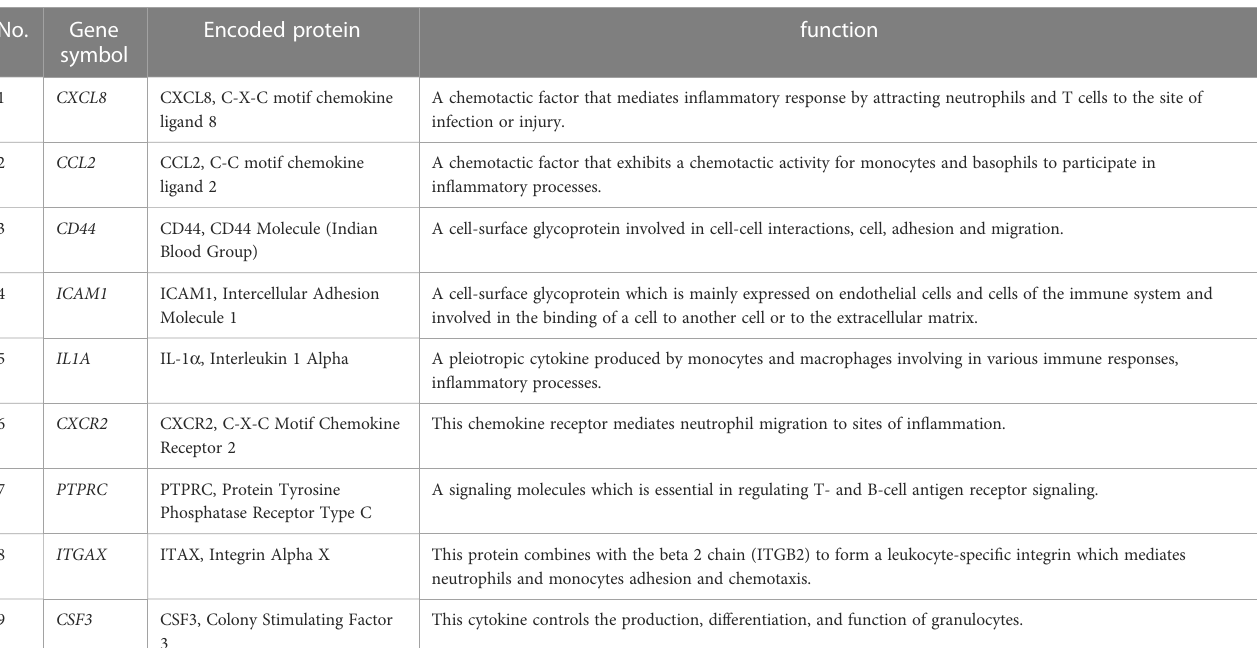
TABLE 3 The details of the candidate hub